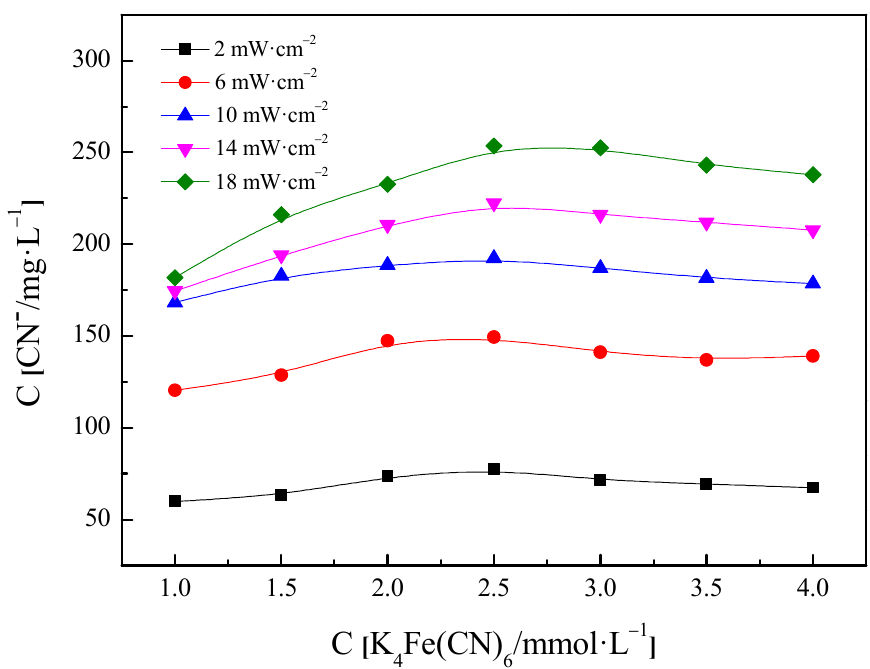
Figure 8. Five different irradiation intensities which were assessed, all with the same reaction time of 30 min (buffered at pH 12).